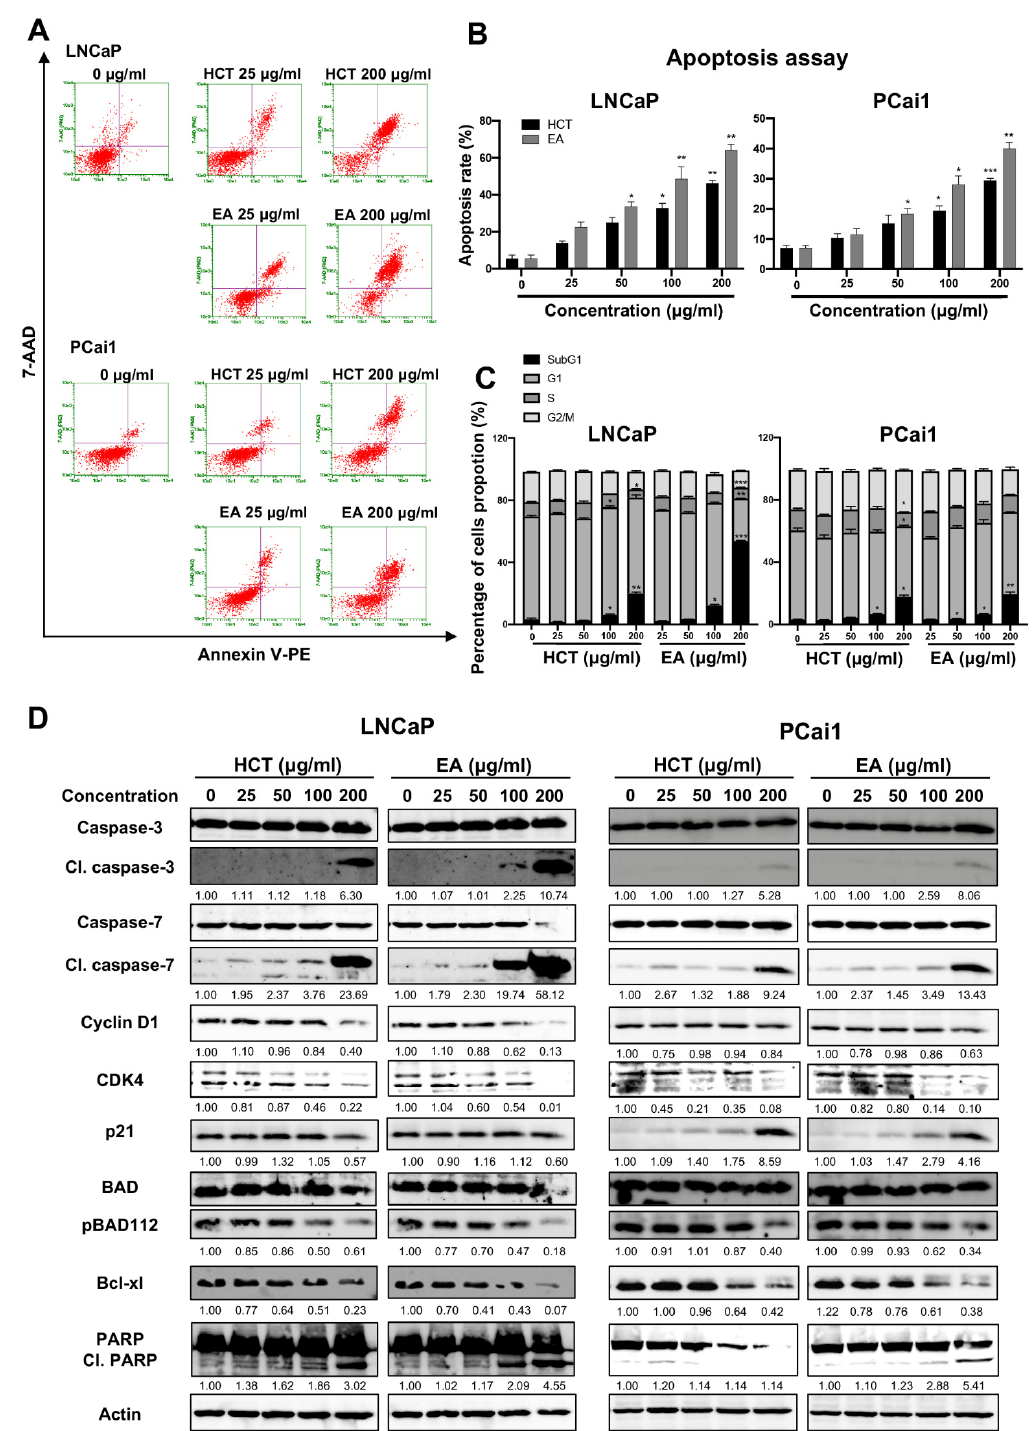
Figure 3. Apoptosis induction by HCT and EA in prostate cancer cell lines. Flow cytometric analysis of apoptosis induction in LNCaP and PCai1 cells treated with HCT and EA for 48 h ( A ). The percentages of apoptotic cells were quantitated using Guava ® ViacountTM Software ( B ). Effects of HCT and EA on the cell cycle of LNCaP and PCai1 cells for 48 h ( C ). Immunoblotting analysis to show the cell proliferation and apoptosis-related proteins in LNCaP and PCai1 cells in response to HCT and EA ( D ). Bar graphs showed the summarized data of three independent experiments and were performed in duplicate compared with the DMSO-treated control. The data represented the means ± SD. Whole un-cropped images see Figure S3. * p < 0.05, ** p < 0.01, and *** p < 0.001 vs. control. HCT, Houttuynia cordata Thunb.; EA, ethyl acetate fraction of H. cordata